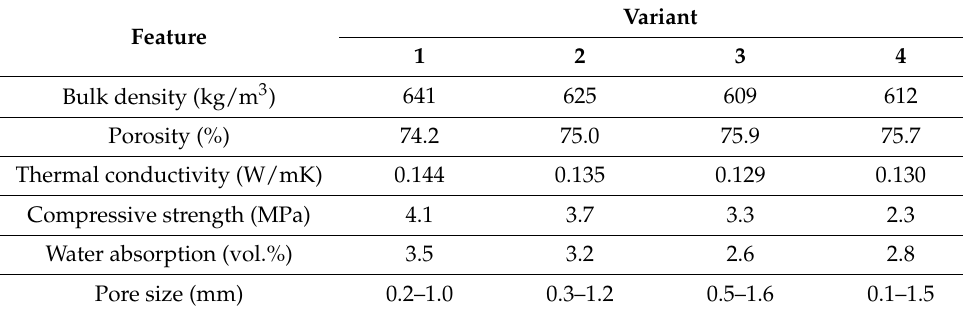
Table 3. The physical, thermal, and mechanical properties of the samples.